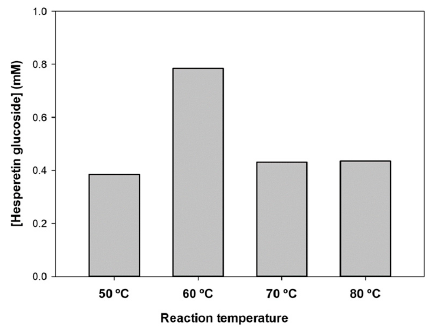
Figure 5. Effect of temperature on the glucosylation of hesperetin. Reaction conditions: hesperetin (6 mg/mL), soluble starch (50 mg/mL), CGTase from Thermoanaerobacter sp. (10% v / v ), sodium citrate 10 mM at pH 5.0 (60% v / v ), bis(2-methoxyethyl) ether (30 % v / v ), 1000 rpm. The reactions were analyzed after 18 h.